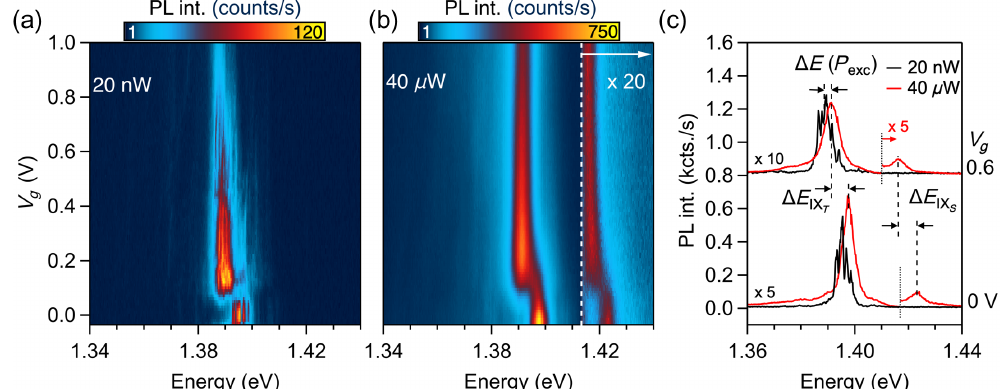
≤ 0 . 1 V) and FIG. 3. Interlayer exciton trions in WSe 2 = MoSe 2 . (a),(b) Gate-voltage-controlled PL of IXs in the neutral ( 0 < V g ≥ 0 . 1 V) at B ¼ 0 T, for P ¼ 20 nW (a) and P ¼ 40 μ W (b) at 4 K. In (b), the PL intensity is electron-doping regime ( V g z exc exc multiplied by a factor 20 in the spectral range delimited by the vertical dashed area for visualization purposes. (c) Line cuts extracted ¼ 0 V) and electron-doping regimes from the color plots in (a) and (b) (black and red solid lines, respectively) in the neutral ( V g ¼ 0 . 6 V). The spectra are normalized by the values indicated in the figure, and the line cuts at V ¼ 0 . 6 V are shifted vertically for ( V g g visualization purposes. The dashed vertical lines indicate the central energies of the different ensemble peaks, illustrating the power- Þ ] and the energy splittings arising from the binding energies of the charged IXs with spin-triplet ( Δ E induced blueshift [ Δ E ð P ) and exc IX T spin-singlet ( Δ E ) IX S